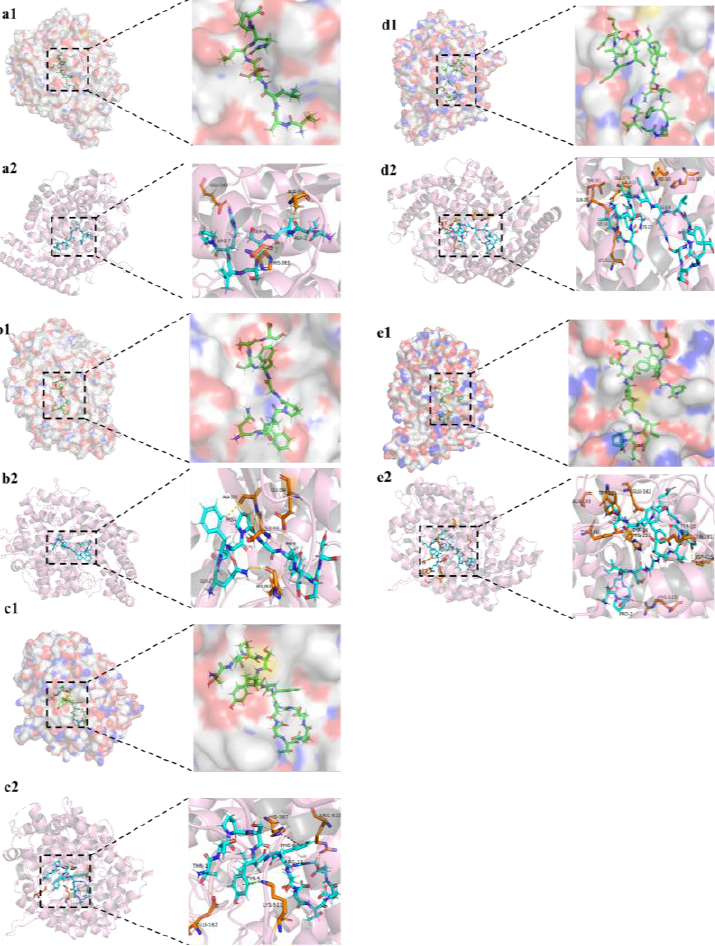
Figure 4. Three-dimensional binding mode of peptide VALSSLRP to ACE ( a1 ); Intermolecular interaction between peptide VALSSLRP and ACE ( a2 ). Three-dimensional binding mode of peptide QFQPGFSSS to ACE (b1 ); Intermolecular interaction between peptide QFQPGFSSS and ACE ( b2 ). Three-dimensional binding mode of peptide TTPSYVAFTDTER to ACE ( c1 ); Intermolecular interaction between peptide TTPSYVAFTDTER and ACE ( c2 ). Three-dimensional binding mode of peptide STGEAFVQFASQEIAEK to ACE ( d1 ); Intermolecular interaction between peptide STGEAFVQFASQEIAEK and ACE ( d2 ). Three-dimensional binding mode of peptide NPDDITNEEYGEFYK to ACE ( e1 ); Intermolecular interaction between peptide NPDDITNEEYGEFYK and ACE ( e2 ). Yellow dash indicates H bonding; red dash indicates π - π interaction; green dash indicates π -cation interaction.